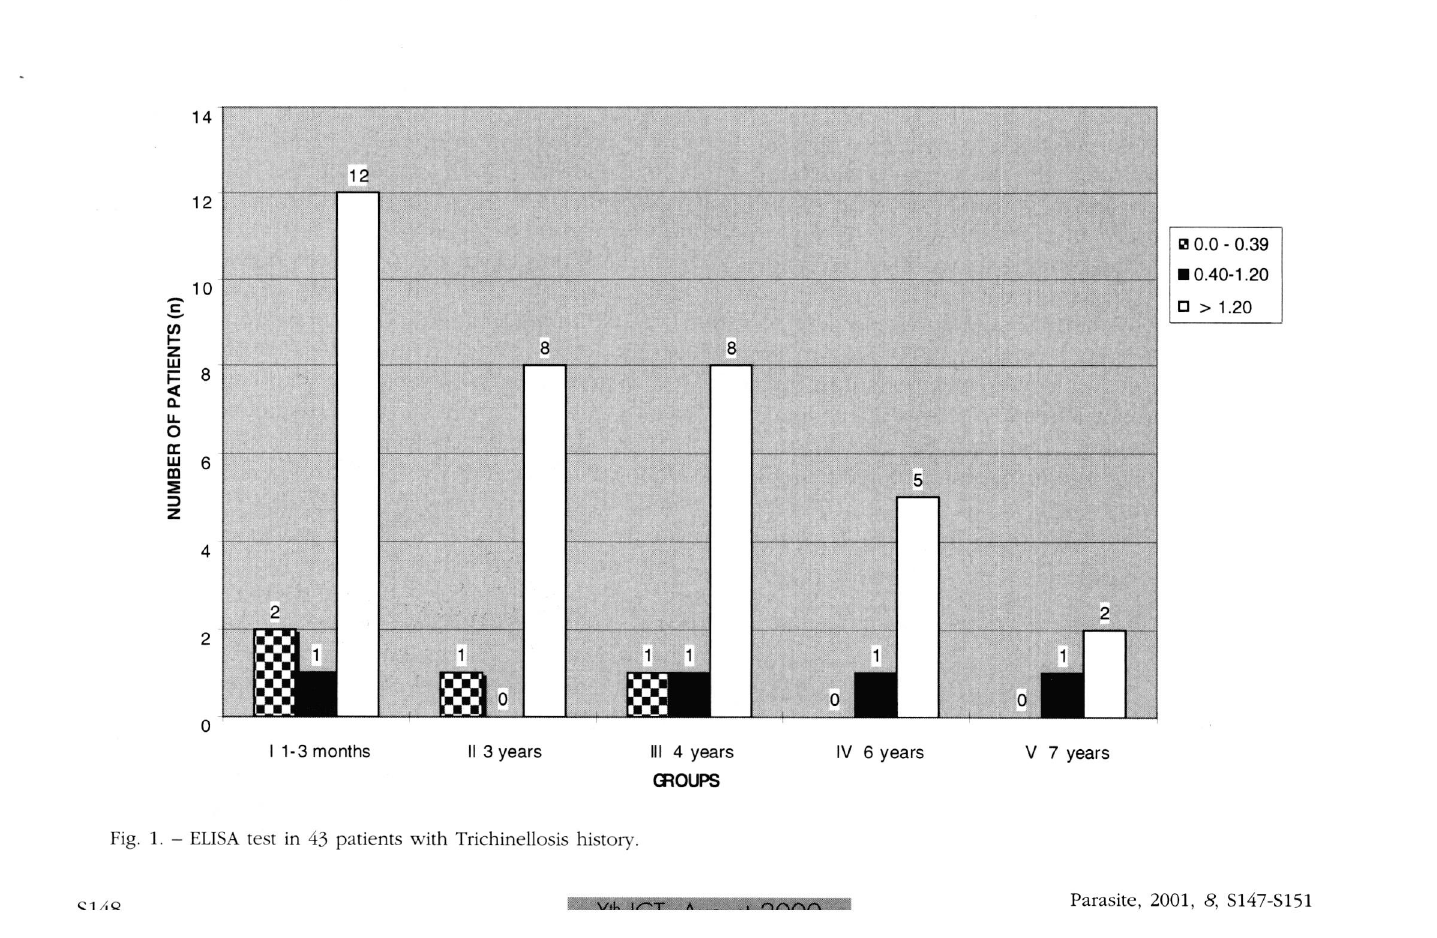
Fig. 1. - ELISA test in 43 patients with Trichinellosis